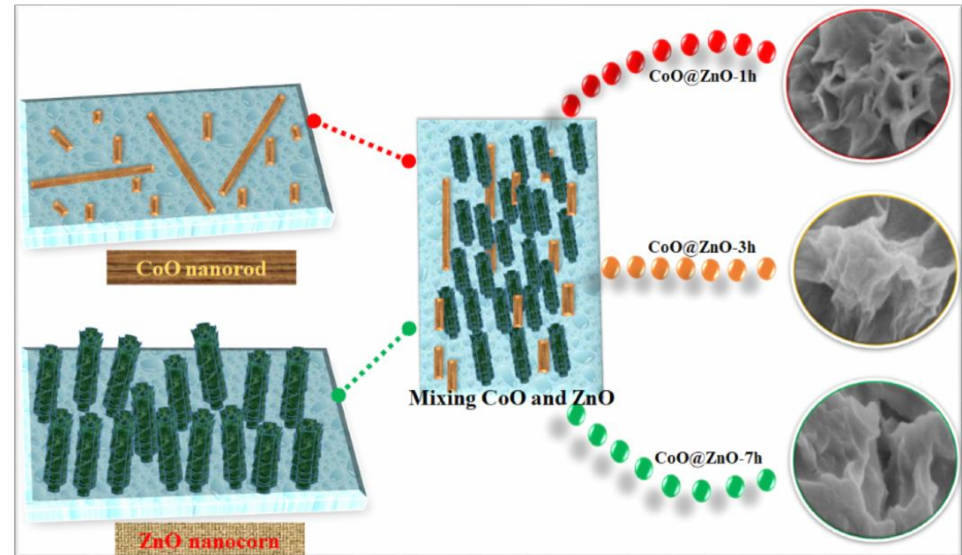
Figure 1. Illustration of the synthesis process of various nanostructures of CoO and ZnO and the effect of time on CZ composite electrodes on the Ni foam.